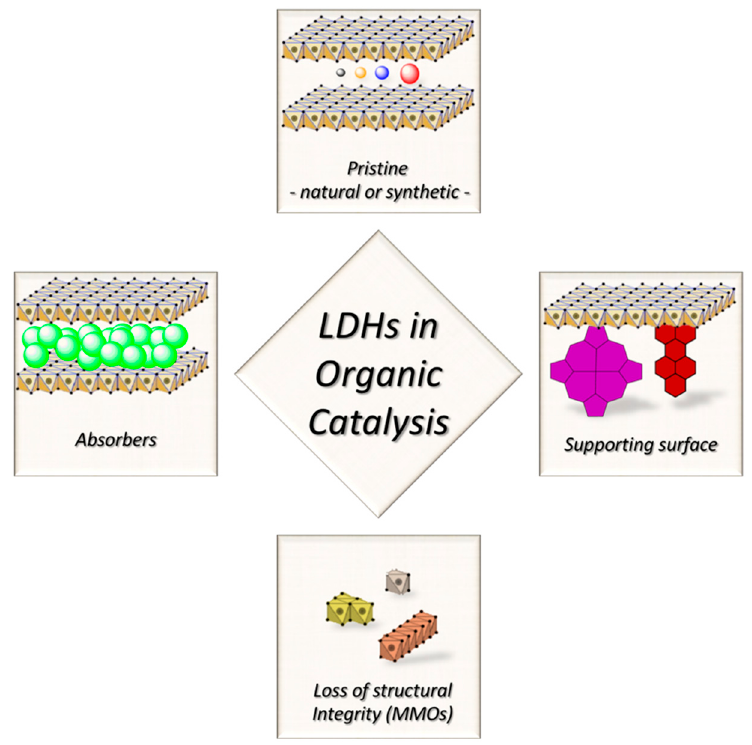
Figure 2. Representation of different possible approaches for the development of LDH ‐ based catalysts for organic synthesis.